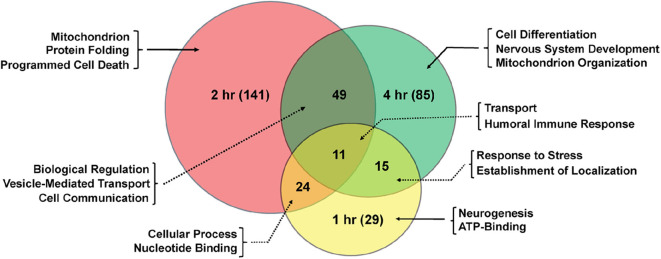
Shared gene ontology terms in females across time-points after injury. The Venn diagram shows significantly changed GO terms for females at 1, 2, and 4 hr after injury as well as overlap between time-points. The number of GO terms differentially regulated at each time-point is indicated in parenthesis.